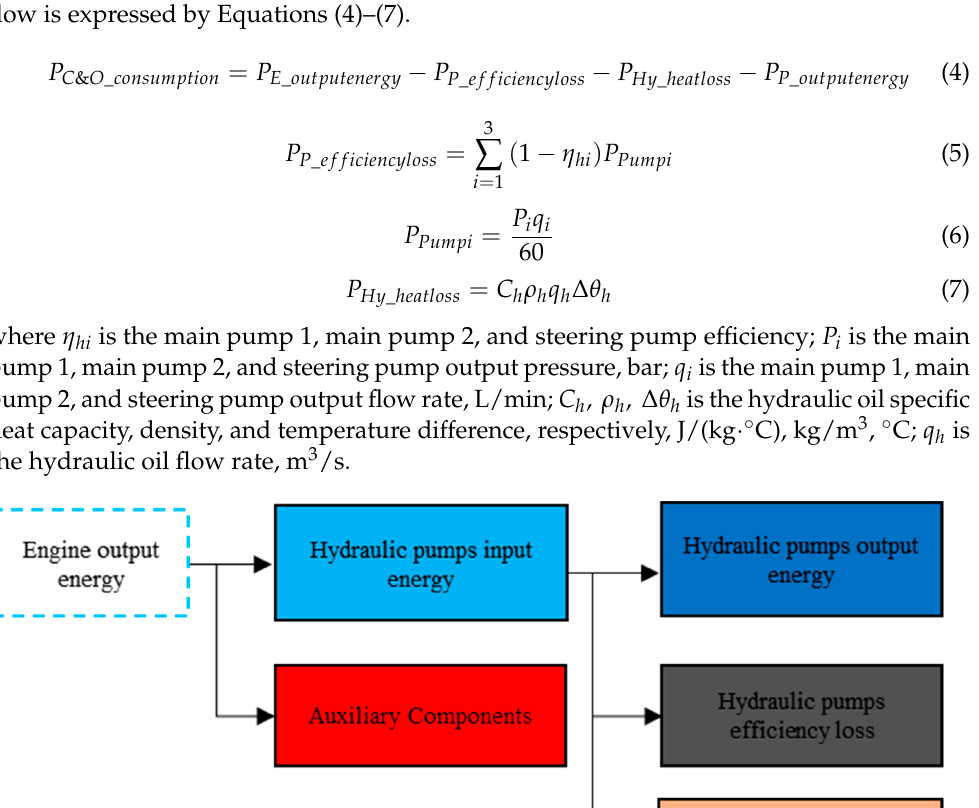
Figure 3. Engine energy flow.